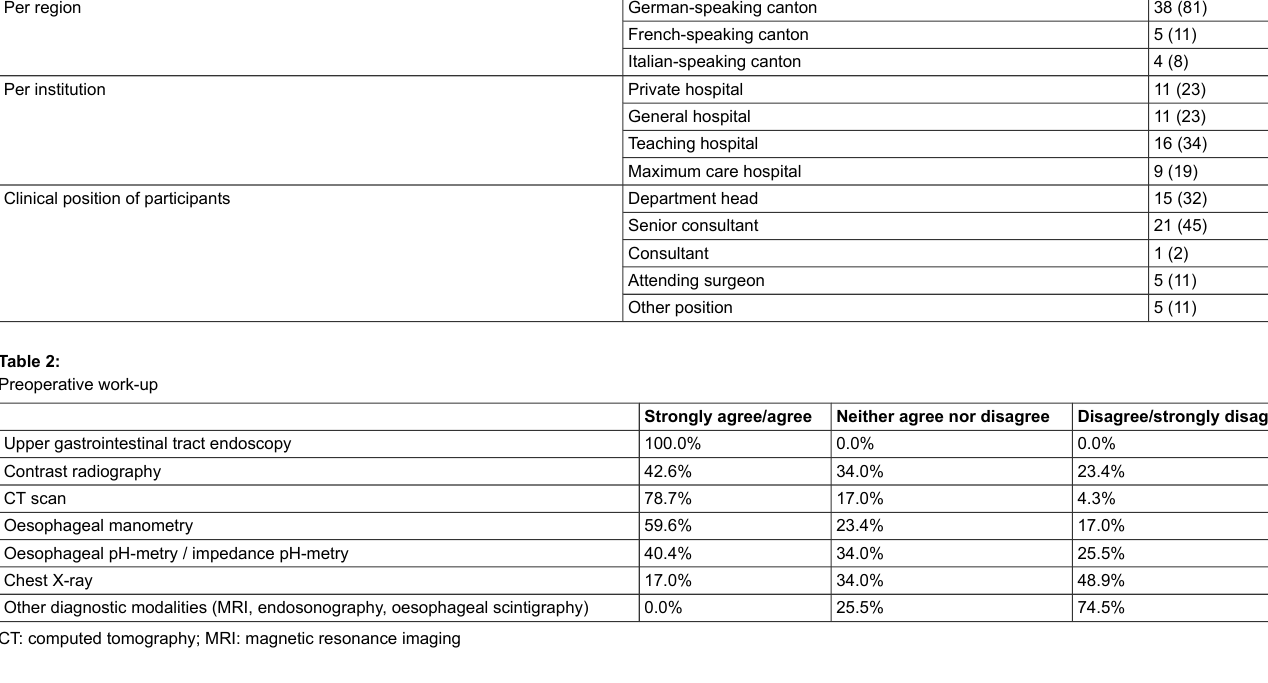
Table 1: Participating experts and institutions. Participating expert characteristics